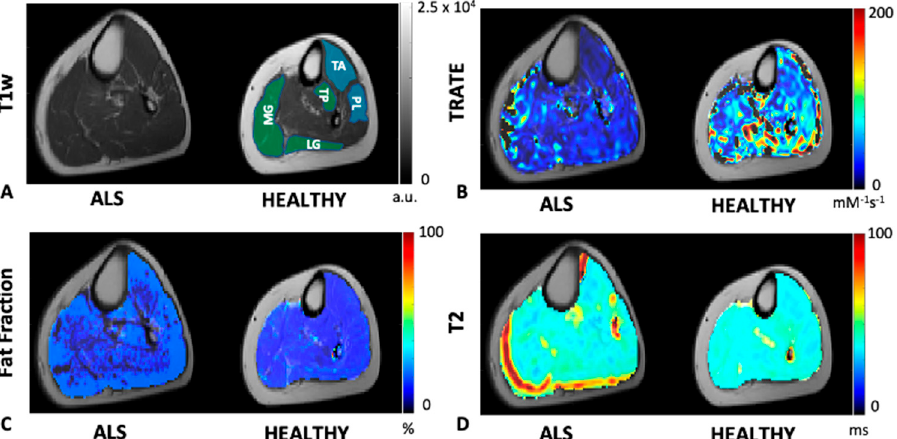
Figure 1. A comparison of time-dependent CA concentration curves ( left ) and transverse relaxa- tion rate changes ( right ) obtained in the tibialis anterior muscle compartment of an ALS patient and a healthy control.